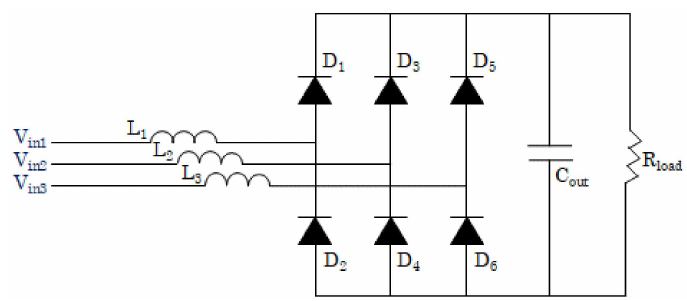
Figure 21. Three phase diode bridge architecture.